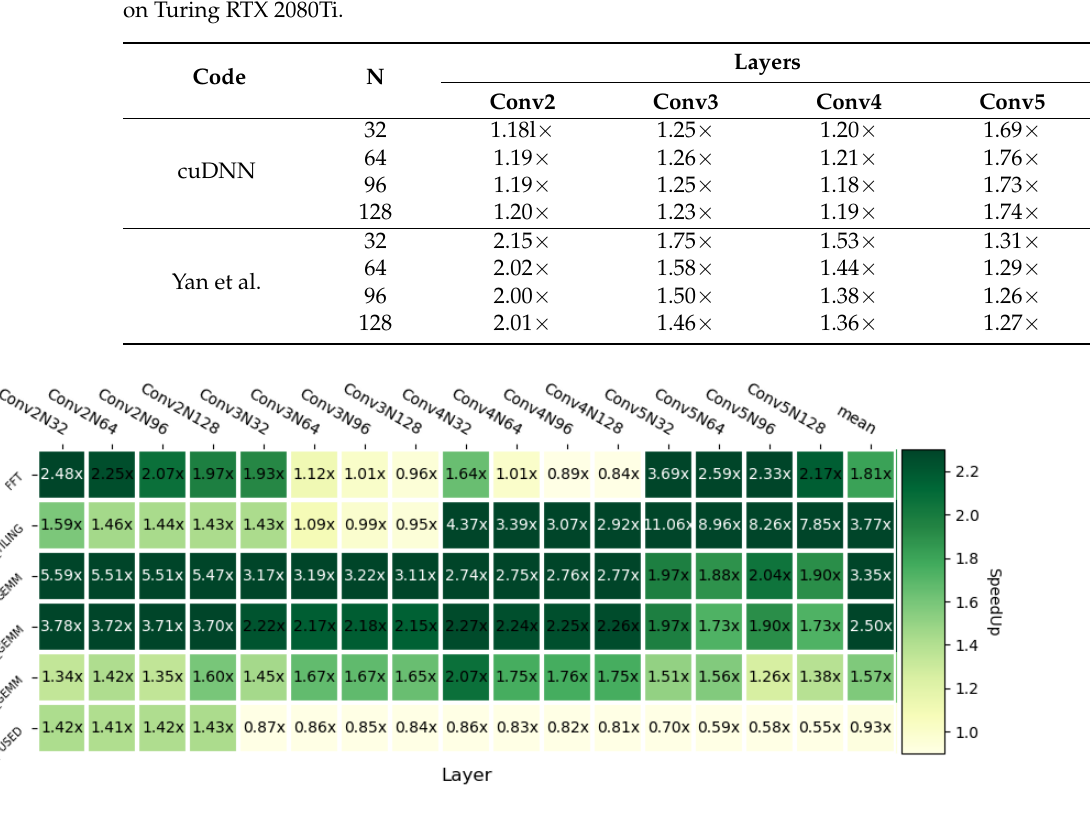
Figure 17. Heatmap with respect to other cuDNN convolution algorithms on Turing RTX 2080Ti.